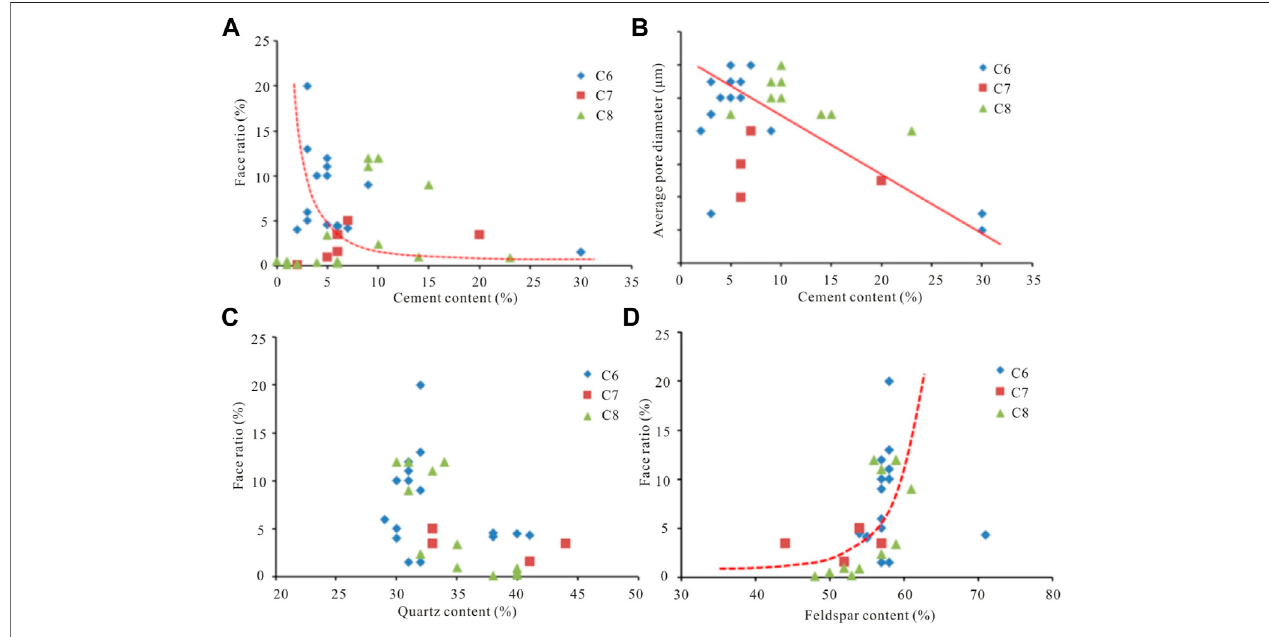
FIGURE 3 | Effects of different types of mineral components on petrophysical properties of tight oil reservoirs. (A) Relationship between cement content and face ratio; (B) Relationship between cement content and average pore diameter; (C) Relationship between quartz content and face ratio; (D) Relationship between feldspar content and face ratio.